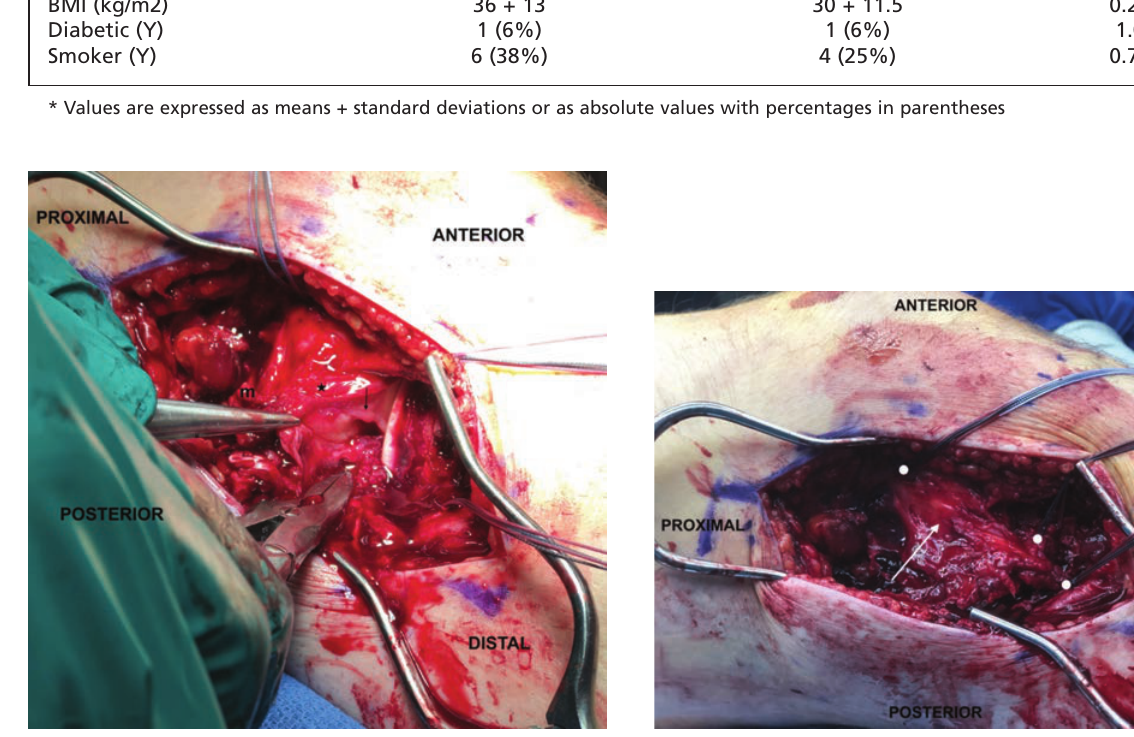
Traumatic MCL rupture (‘m’) to left knee with capsular Fig. 1: (star) and meniscal disruption (arrow).